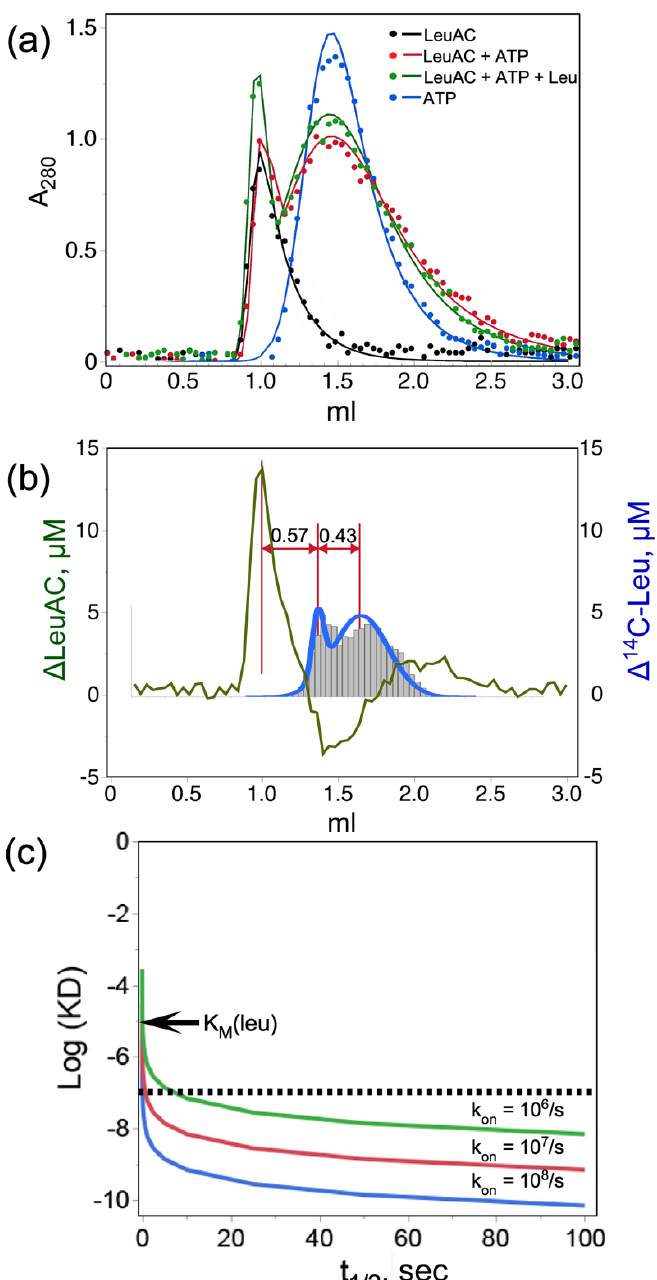
Figure 4. Quantitative size exclusion chromatography of TEV-cleaved LeuAC on G15 Sephadex. ( a ). Profiles for LeuAC, ATP, and reaction mixtures either with or without 5 mM leucine. Experimental points were fitted to a four-parameter exponentially modified normal distribution [31]. ( b ). Quanti- tative deconvolution of overlapping peaks in [LeuAC ± leucine (green)] and [leucine ± LeuAC (blue)] difference profiles show the mutual acceleration by LeuAC and substrate leucine of the other’s eluted position. ( c ). Simulated dissociation constants consistent with the displacement of bound [ 14 C] leucine in ( b ). Values of log(K D ), where K D = k off /k on , are plotted against the half-life of the complex, t 1/2 = 0.693*k off , for reasonable values of k on . The observed displacement in ( b ) repre- sents approximately 10 min or 40% of the total transit time in the G15 support. The abscissa covers an ~100-fold range ending at 100 s, or 1/6th of the actual displacement. Simulated curves are shown for three plausible on-rates. Essentially all possible values for K D are less than 10 −7 M, which is two orders of magnitude tighter than the K M for leucine in Section 2.5.